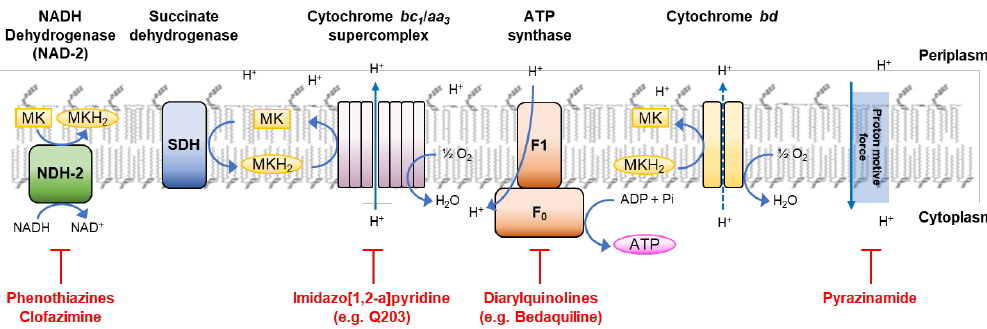
Figure 1. Respiratory electron transport chain (ETC) in Mycobacterium tuberculosis ( Mtb ).